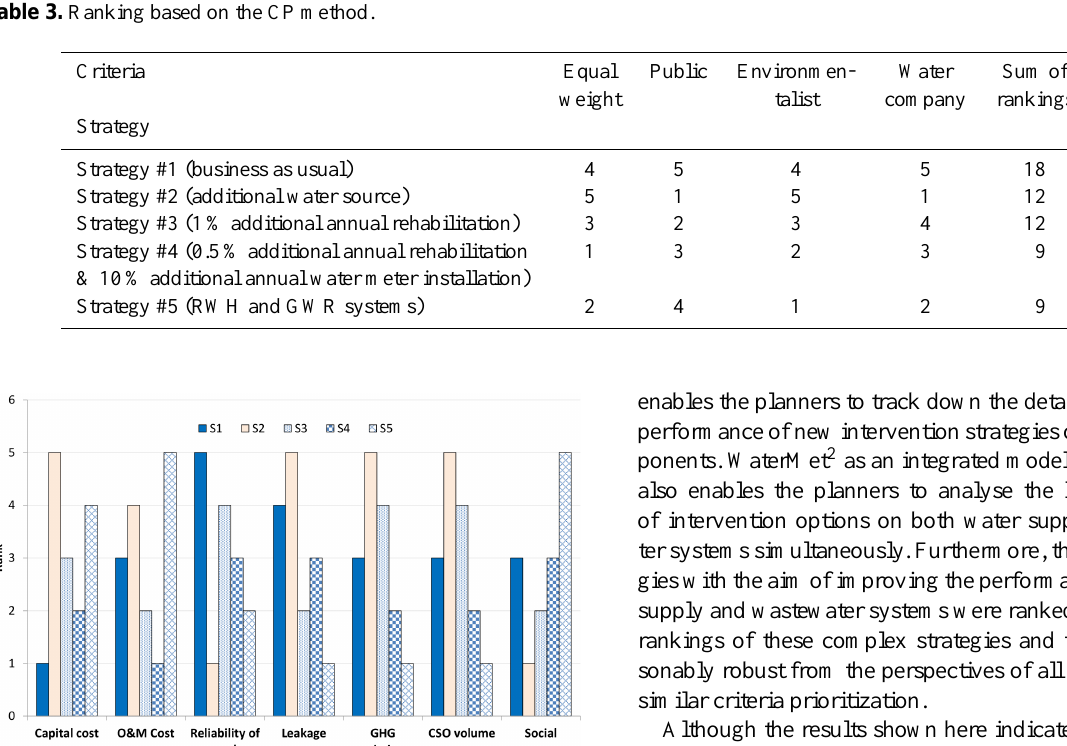
Table 3. Ranking based on the CP method.